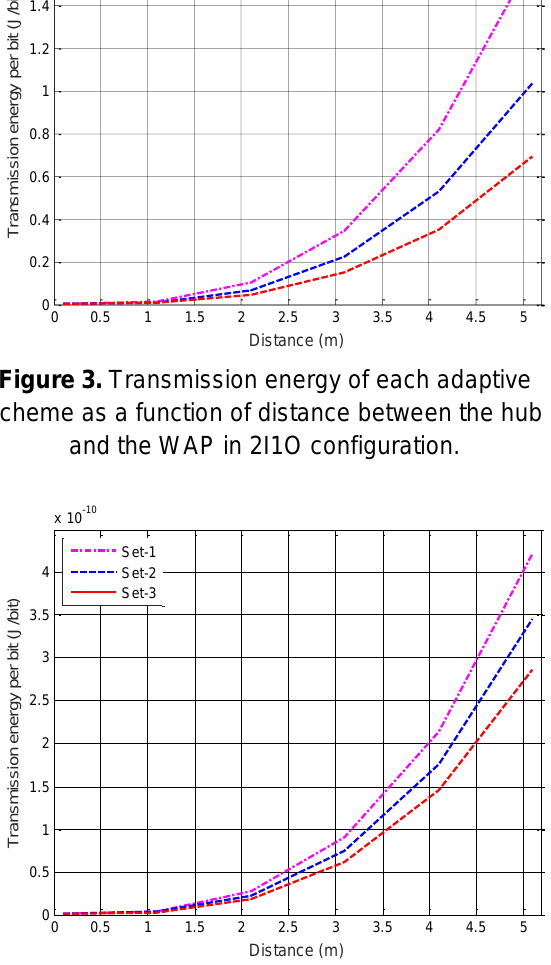
Figure 4. Transmission energy of each adaptive scheme as a function of distance between the hub and the WAP in 2I2O